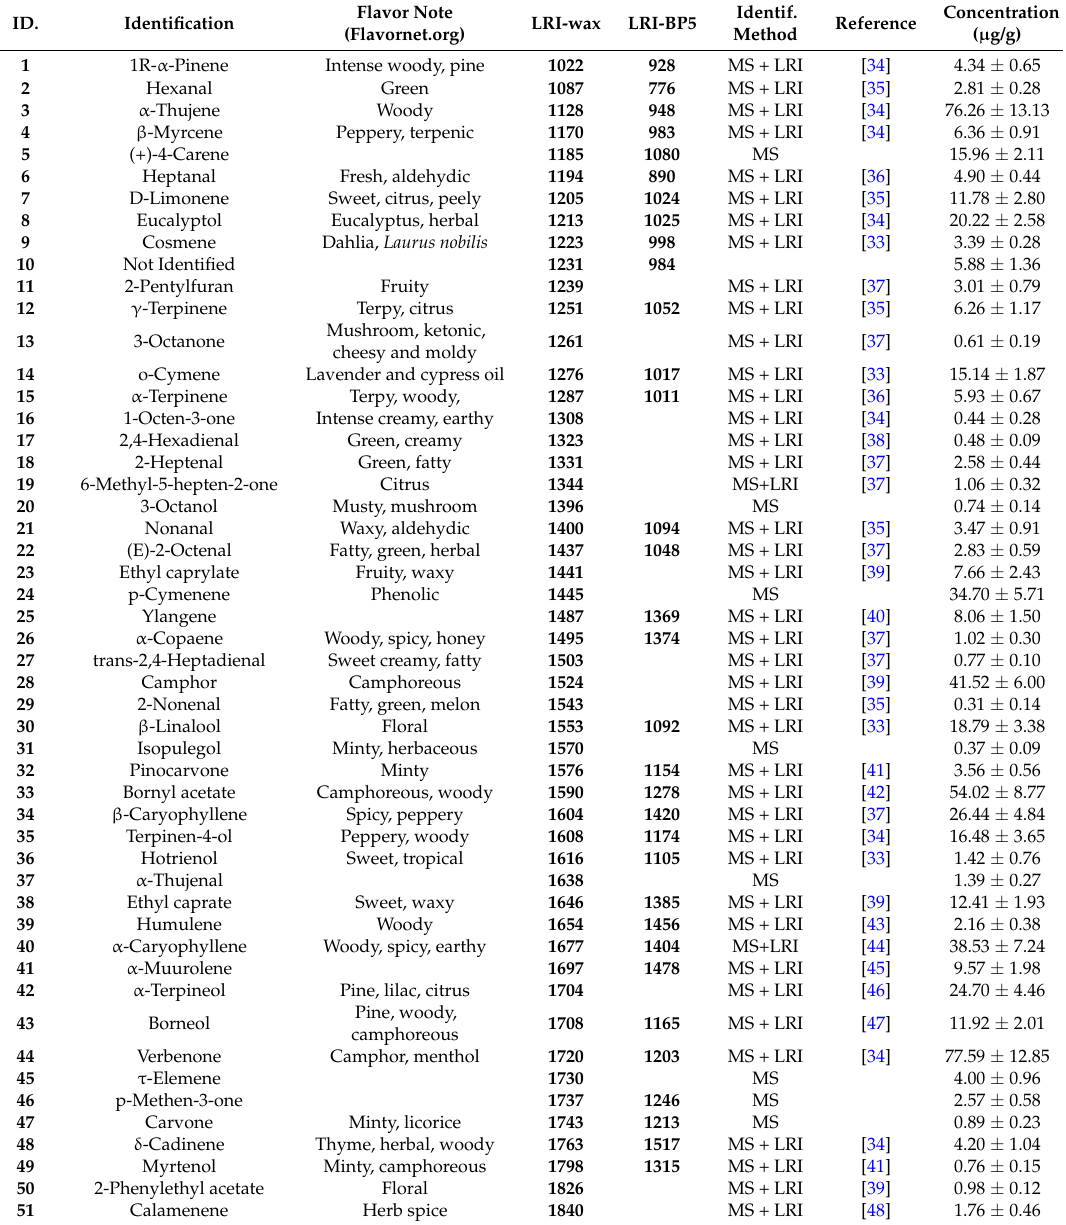
Table 3. Identification of rosemary extract volatile compounds, with relative aromatic notes, calculated linear retention indices (LRIs) on two different stationary phases (“wax” polar and “BP5” a-polar), identification methods, references, and relative amounts (mean ±